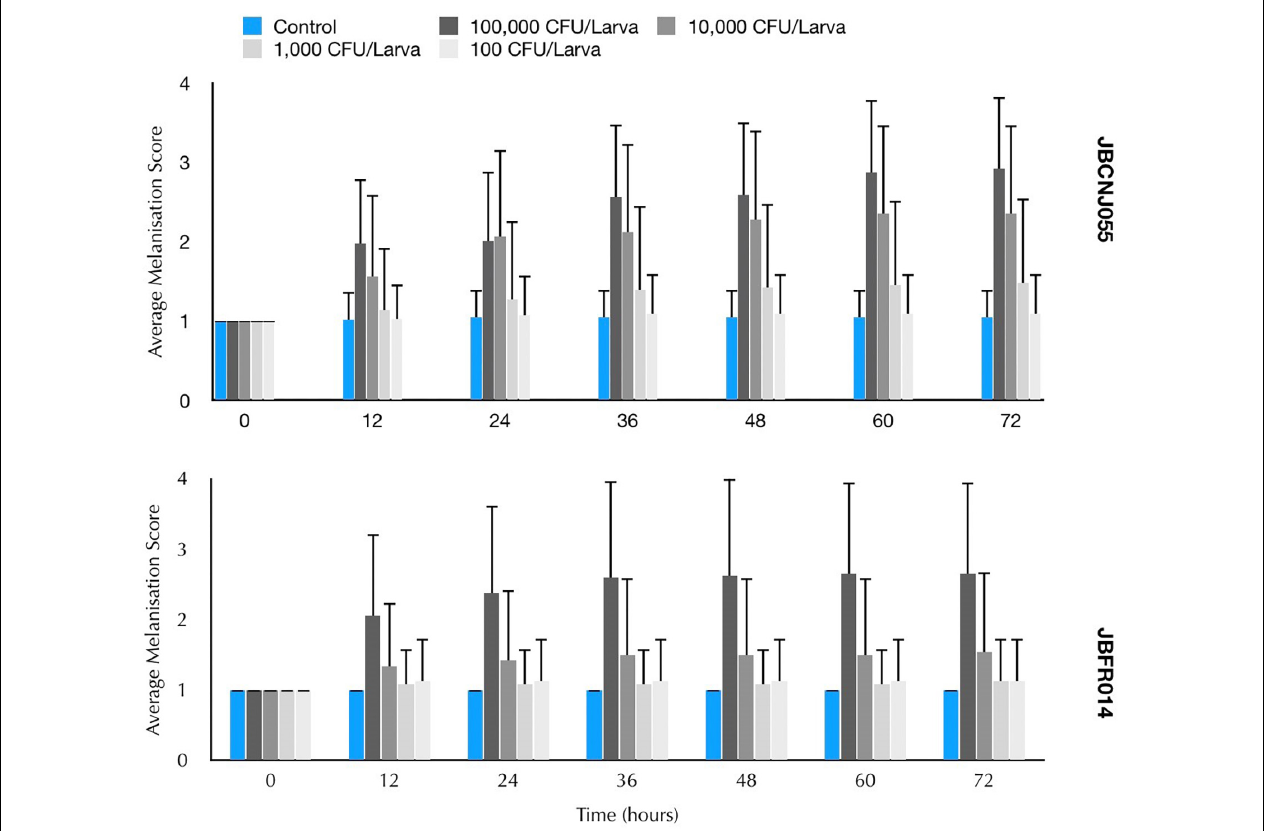
FIGURE 4 | Mean melanisation score of pooled data, 72 h post inoculation of 10 µ L of a range of dilutions from 10 7 to 10 3 CFU/mL of Clostridium perfringens JBCNJ055 and JBFR014. Scoring system is as follows: 1 = healthy, 2 = < 50% melanisation, 3 = > 50% melanisation, 4 = dead. Data shown is pooled from three distinct repeats and error bars represent standard deviation. Injection with 10 µ l of 10 7 was required to cause potent melanisation resulting in scores higher than 3. Survival percentages of G. mellonella after inoculation with 10 µ L of a range of dilutions 10 5 –10 CFU/mL of C. perfringens